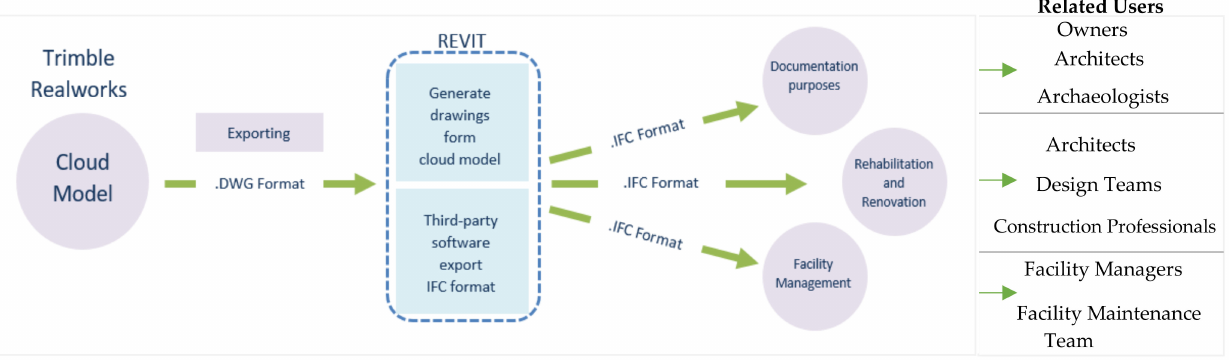
Figure 15. Cloud model integration with BIM